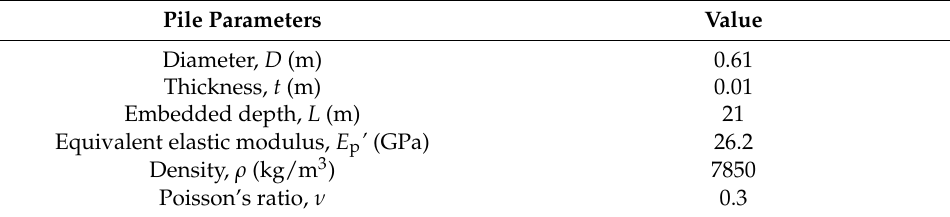
Table 1. Parameters of the pile used in the ABAQUS